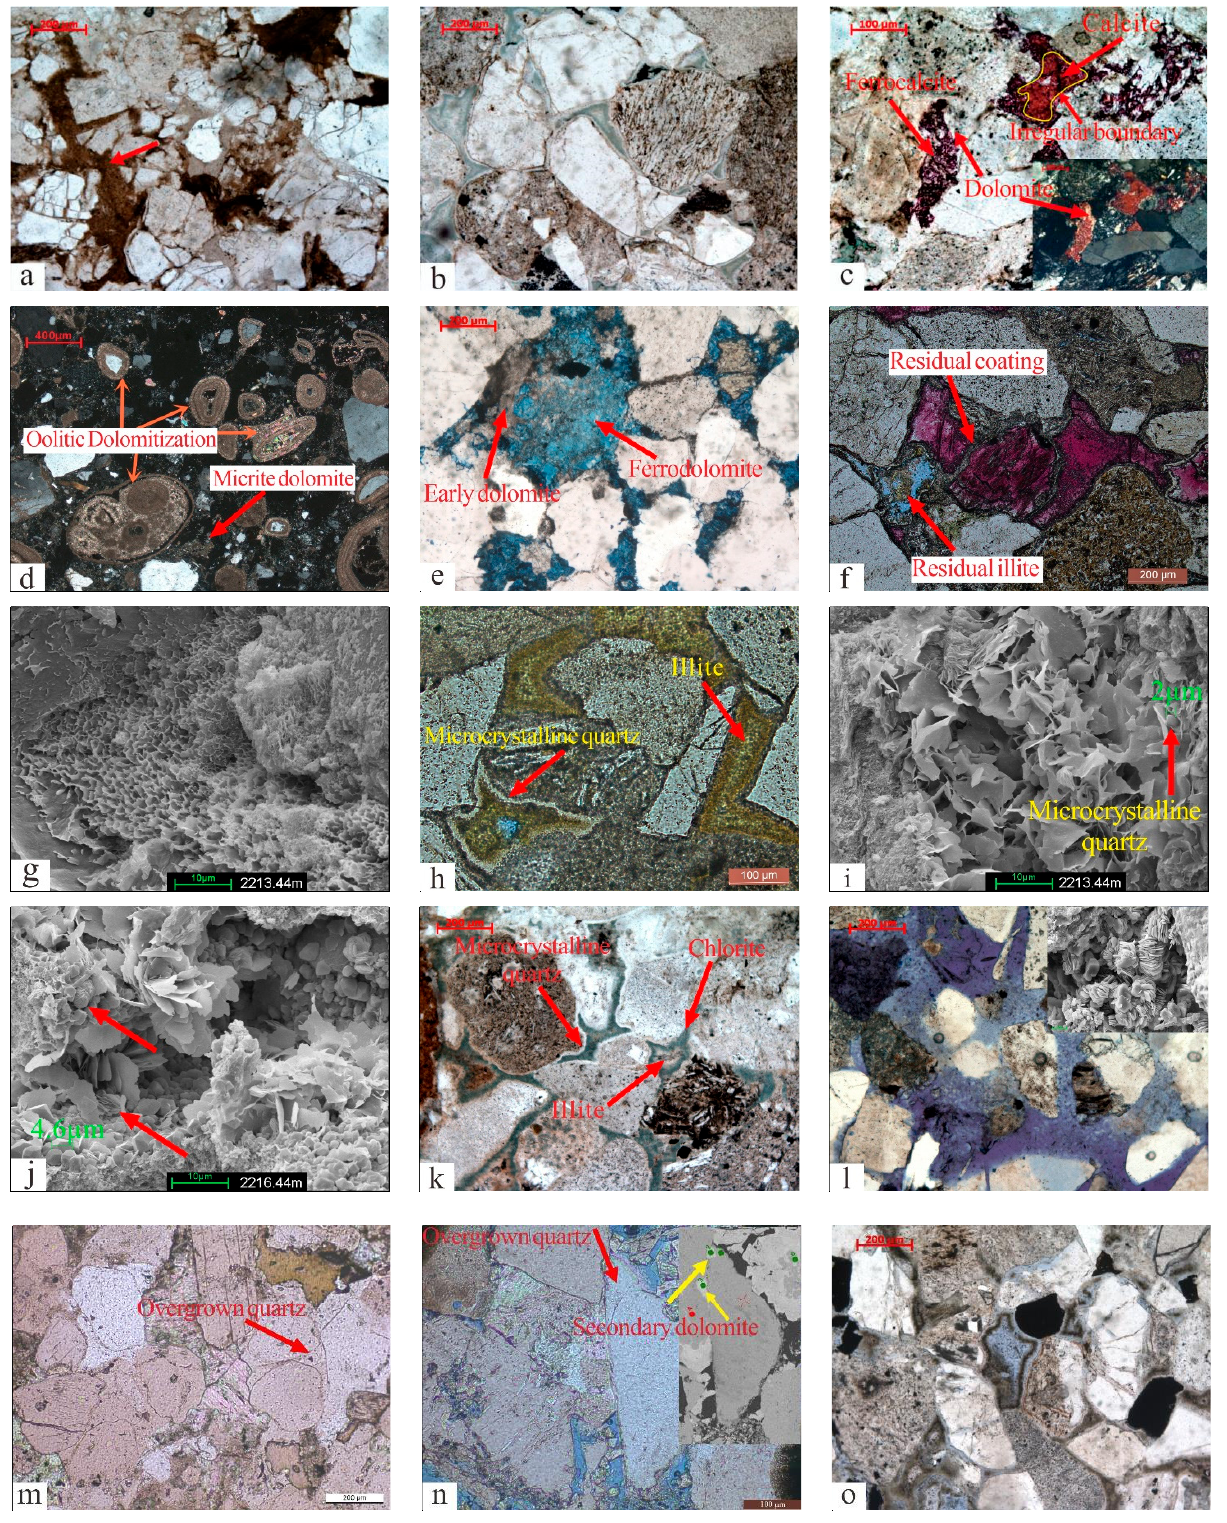
Figure 3. The types of diagenesis. ( a ) Plastic components were compact and deformed (red arrow), QS-1D, 2698.5 m. ( b ) Detrital grains were in point-line contact, and authigenic minerals developed between particles, Q9-1D, 2672 m. ( c ) Ferrocalcite and calcite filled the dissolution pores, with an irregular boundary between two types of calcite. The dissolution pores contained the residual do- lomite due to dissolution, QS-1D, 2427 m. ( d ) Micrite dolomite crystallized between particles, and oolitic was replaced by dolomite, Q9-1D, 2434.45 m. ( e ) Intergranular micrite dolomite was replaced by ferrodolomite, Q9-3, 2409.1 m. ( f ) The coating left by dissolution was covered in ferrocalcite, and the residual illite in intergranular dissolution pores, Q9-3, 2218.01 m. ( g ) Illite/smectite mixed min- erals filled the space between particles, Q9-3, 2213.44 m. ( h ) Pores filled with microcrystalline quartz and illite, Q9-3, 2212.58 m. ( i ) Pores filled with flake illite and microcrystalline quartz, Q9-3, 2213.44 m. ( j ) Rose-shaped chlorite formed after microcrystalline quartz (red arrow), Q9-3, 2216.44 m. ( k ) Pores filled with chlorite, microcrystalline quartz, and residual illite, Q9-2, 2033 m. ( l ) Feldspar dis- solution left grainy kaolinite, Q9-1D, 2849.7 m. ( m ) Overgrown quartz developed between grains, Q9-3, 2424.26 m. ( n ) Secondary dolomite was encased in overgrown quartz and appeared rhombo- hedral (yellow arrow), Q9-3, 2423.82 m. ( o ) Intergranular pores formed by the dissolution of clay minerals, Q9-3, 2218.74 m. 4.2. Geochemical Data of Authigenic Minerals 4.2.1. Major Elements The EPMA was performed on the particle coating, feldspar particles, calcite, and do- lomite. The results are shown in Table 1. Late dolomite had a higher FeO content than early dolomite, and the relative content distribution was 17.82 – 25.45%. The content of late calcite was tested by the EPMA. However, the elemental composition of C1 was not iden- tified. The element distribution of particle coating was determined, and even within the same coating, such as the numbers 1#3 and 1#4 in Table 1, the element distribution showed significant differences (Figure 4). Table 1. The chemical composition (mass fraction, wt%) of minerals in the study area. Well Number *